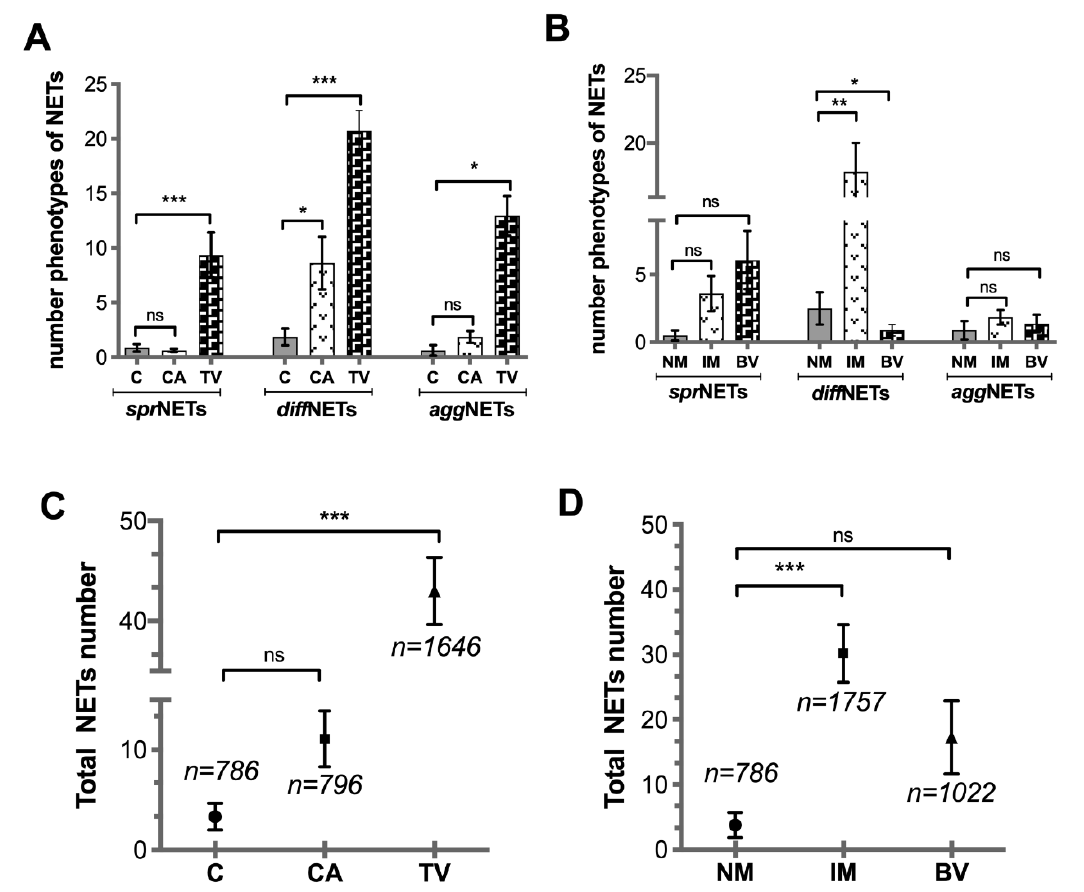
Figure 5. Quantification of the different NET structures. The graph in ( A ) shows types of NETs in pathological vaginal discharges classified according to the infection (CA and TV) and control ( C ); the graph in ( B ) shows the quantification of different types of NETs in groups classified according to microbiota (MN, IM, and BV). The graphs in ( C , D ) show the total NETs in groups classified according to the type of infection and types of microbiota, respectively. The data are indicated as mean ± SD (* p < 0.05, ** p < 0.01, *** p < 0.001).